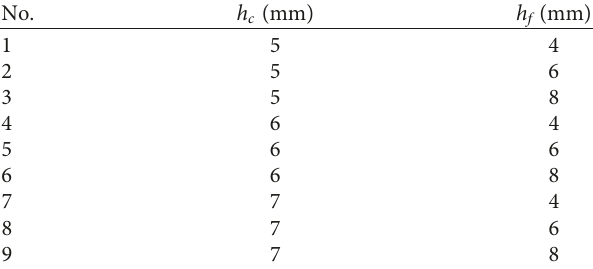
Table 7: Experimental design.